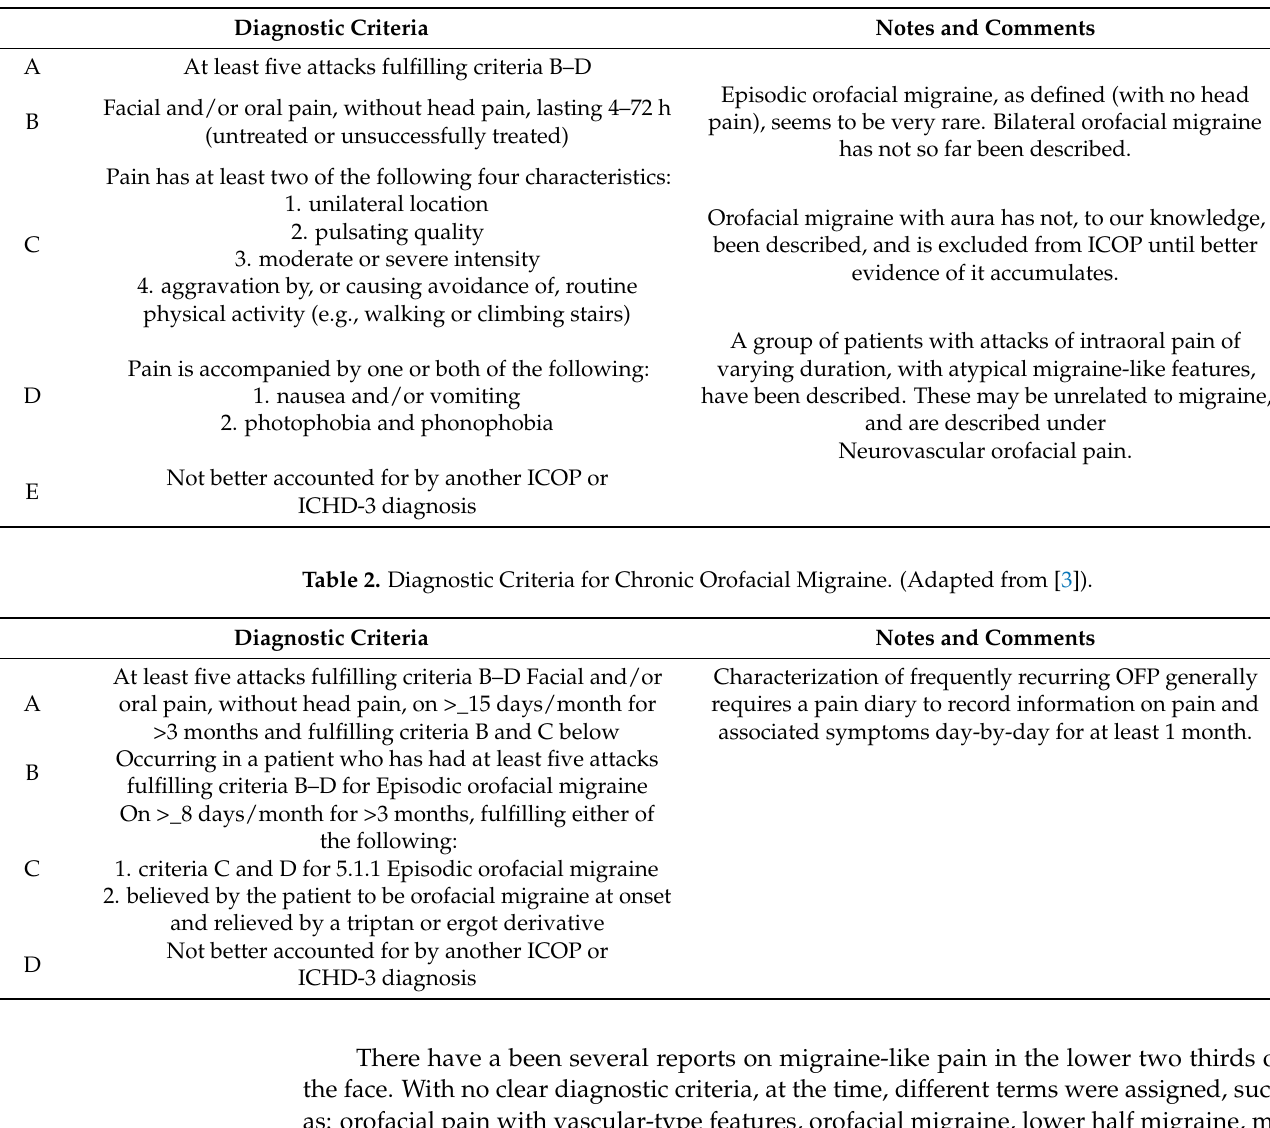
Table 1. Diagnostic Criteria for Episodic Orofacial Migraine. (Adapted from [3]).